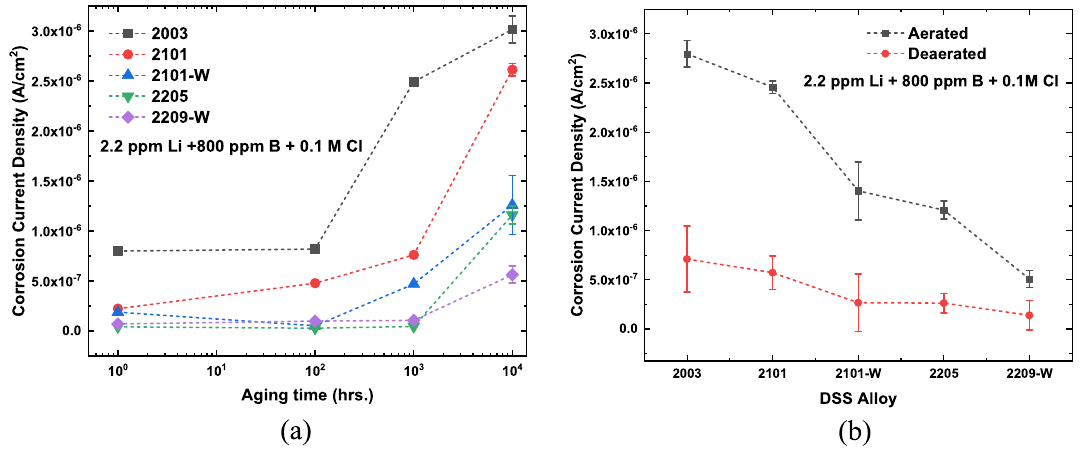
Fig. 11 Corrosion current density in base solution with chlorides for a all the DSS alloys increase with thermal aging time, and b effect of oxygen content on corrosion current density for all tested DSS alloys at 10,000 h of aging in the presence of